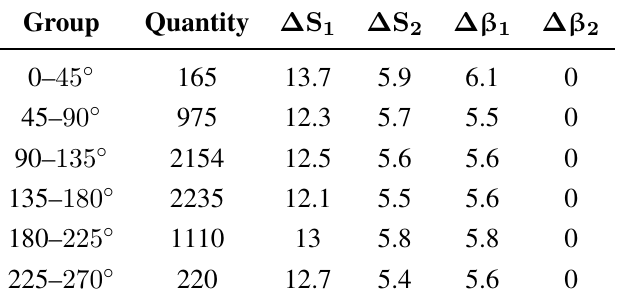
Table 1. Number of configurations for 6 groups of total active movement (TAM).